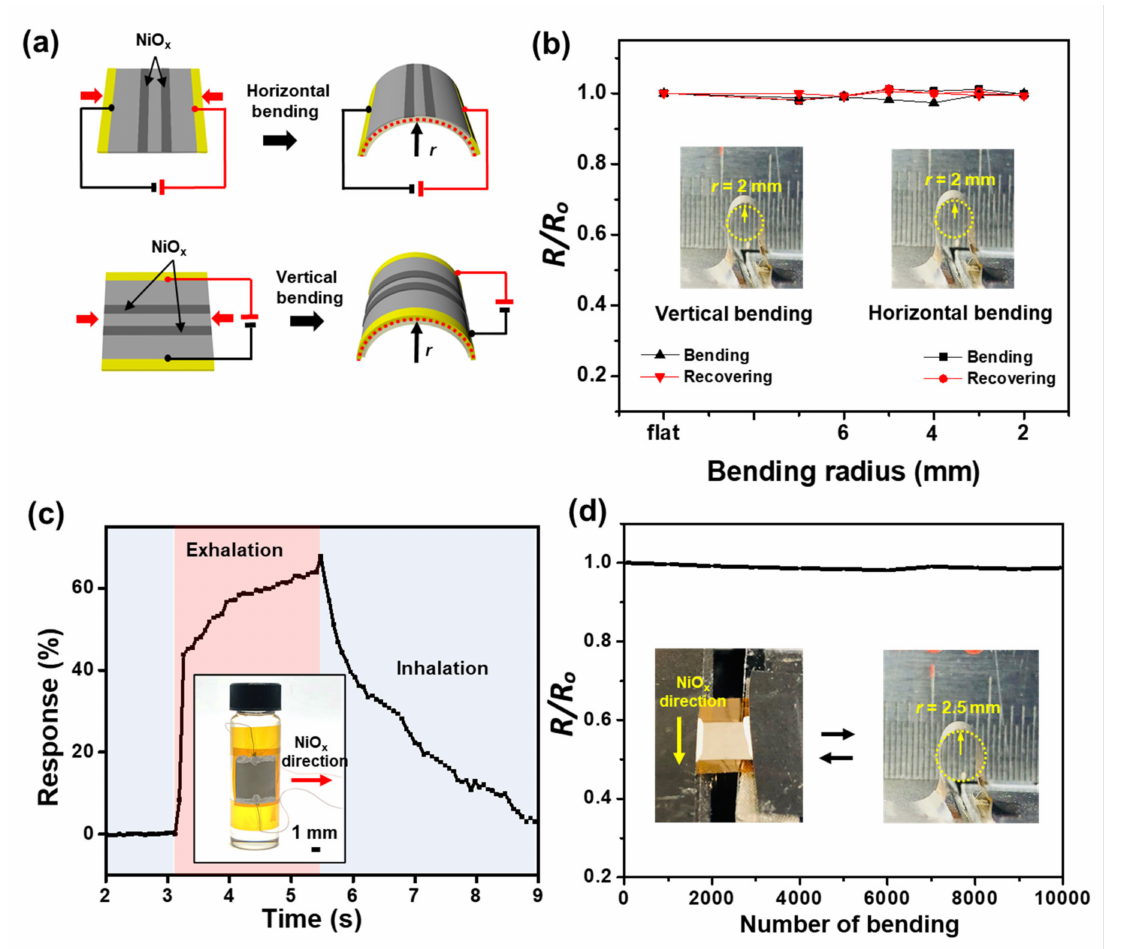
Figure 6. ( a ) Schematic illustration of the horizontal bending and vertical bending states of the sensor. ( b ) Electrical resistance change ( R/R o ) of the breath sensor under various bending radii under each bending state. ( c ) Response curve of the Ni/NiO x -based breath sensor to the normal breathing rate at the operating temperature of 50 ◦ C under a bending condition. ( d ) Relative resistance changes of the breath sensor during a cyclic bending test (10,000